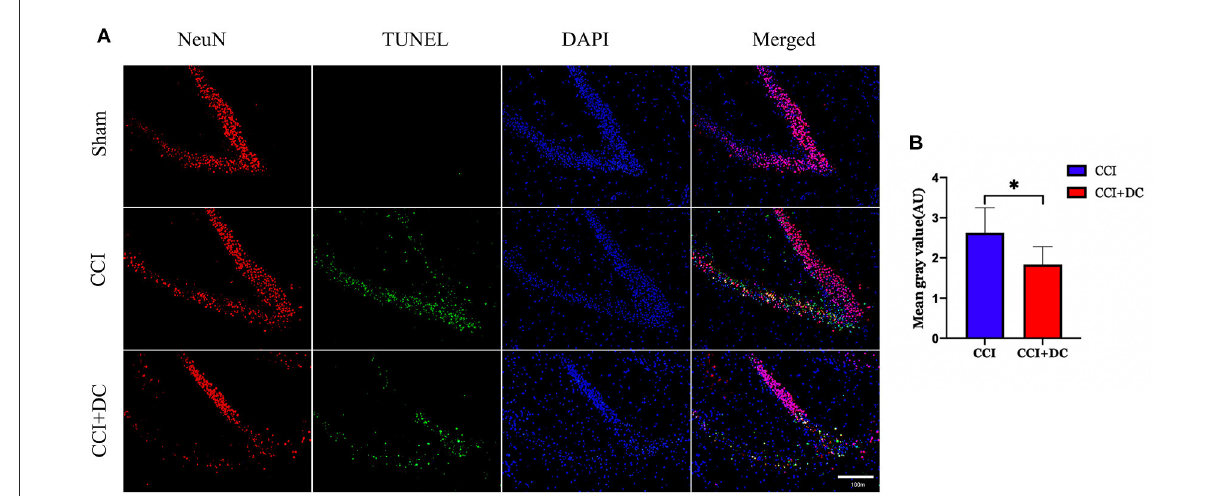
FIGURE12 The effect of neuronal apoptosis in hippocampus on the third day after brain injury. (A) On the 3rd day after brain injury, the apoptosis of hippocampal neurons in different groups. (B) Hippocampal neurons apoptosis on the 3rd day after CCI. The results showed that the neuronal apoptosis of the CCI + DC group was less than that of the CCI group, and the difference was statistically significant ( n = 5/group, * P < 0.05, vs. CCI